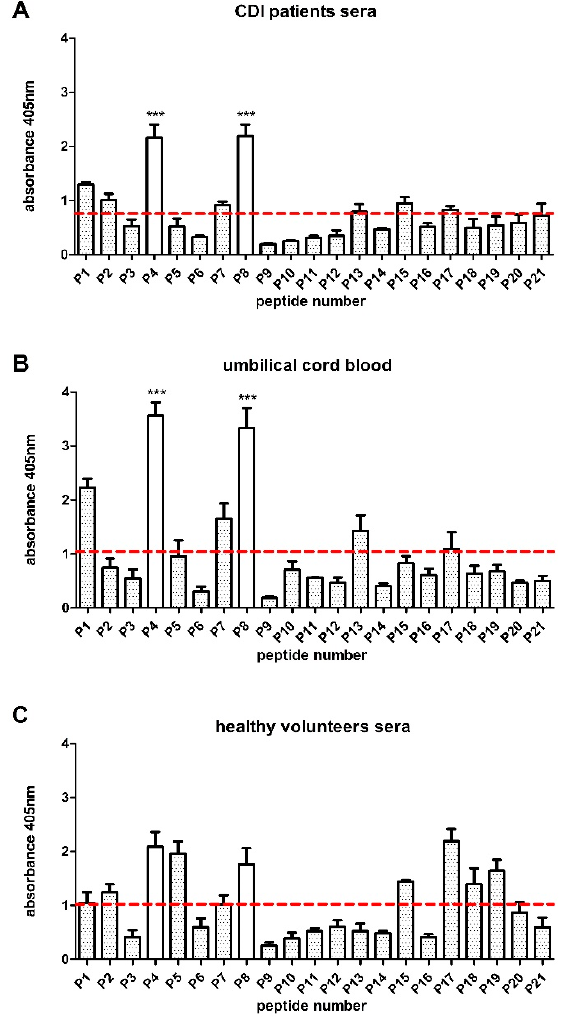
Figure 3. Immunoreactivity of pin-bound peptides with tested groups of sera: ( A ) CDI patients’ sera; ( B ) umbilical cord blood sera; ( C ) healthy volunteers’ sera. Sera antibodies (used in dilution of 1:1000) bound to epitopes were recognized by anti-human IgG secondary antibodies conjugated with AP. Colorimetric reaction was developed with AP ellow Substrate and the result was measured spectrophotometrically at λ = 405 nm. ELISA was repeated at least three times. The dotted line is a counted baseline. Data are shown with mean and ±SD. 2-way ANOVA and Bonferroni posttest were performed. Significant differences were counted for each peptide comparing to the baseline (*** p ≤ 0.001).